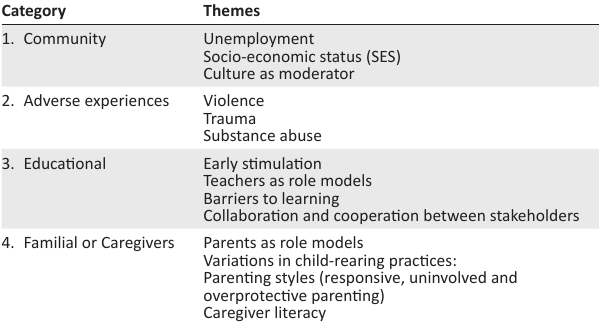
TABLE 1: Factors influencing school readiness